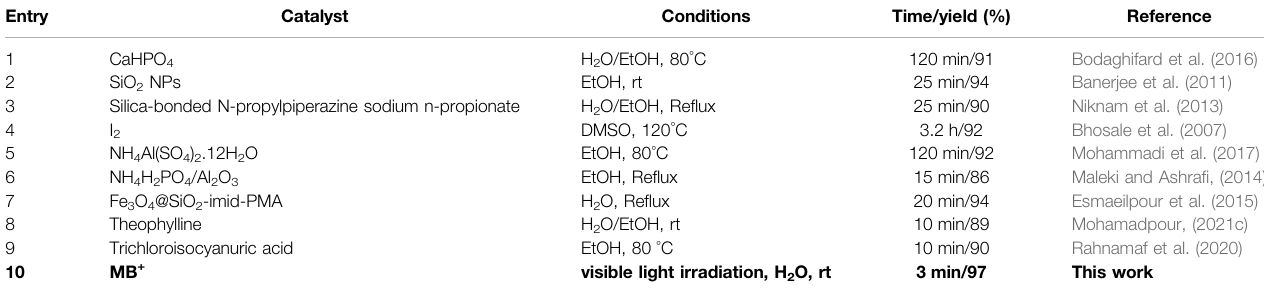
TABLE 5 | Comparing the catalytic characteristics of different catalysts described in the text for the production of catalyst 4a a